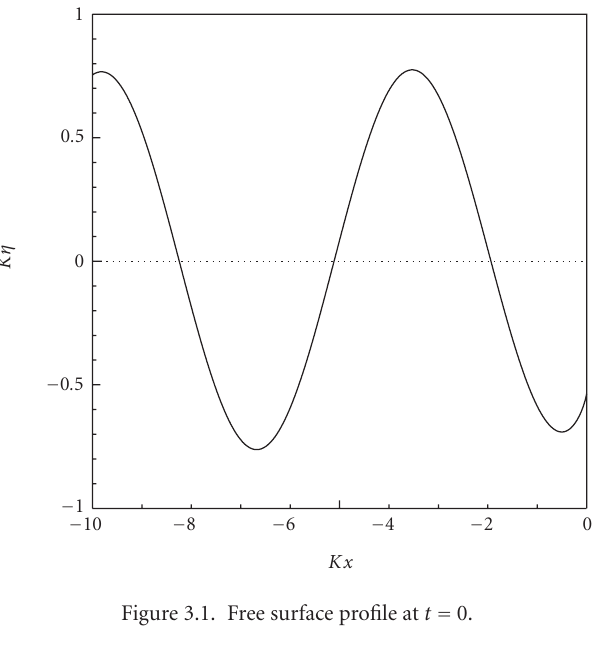
Figure 3.1. Free surface profile at t = 0.